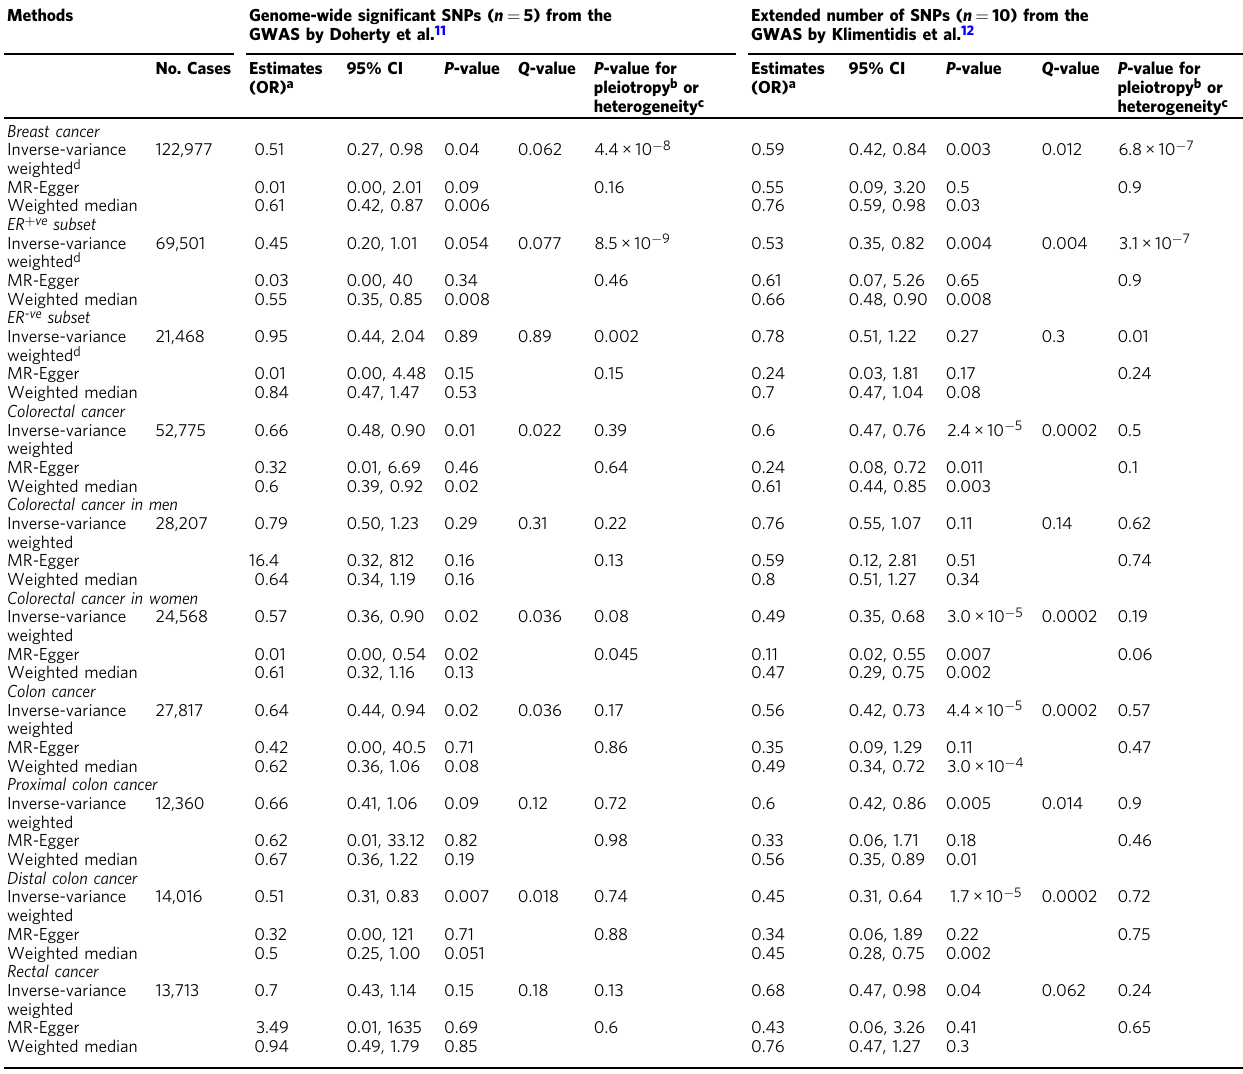
Table 1 Mendelian Randomisation estimates between accelerometer-measured physical activity and cancer risk.